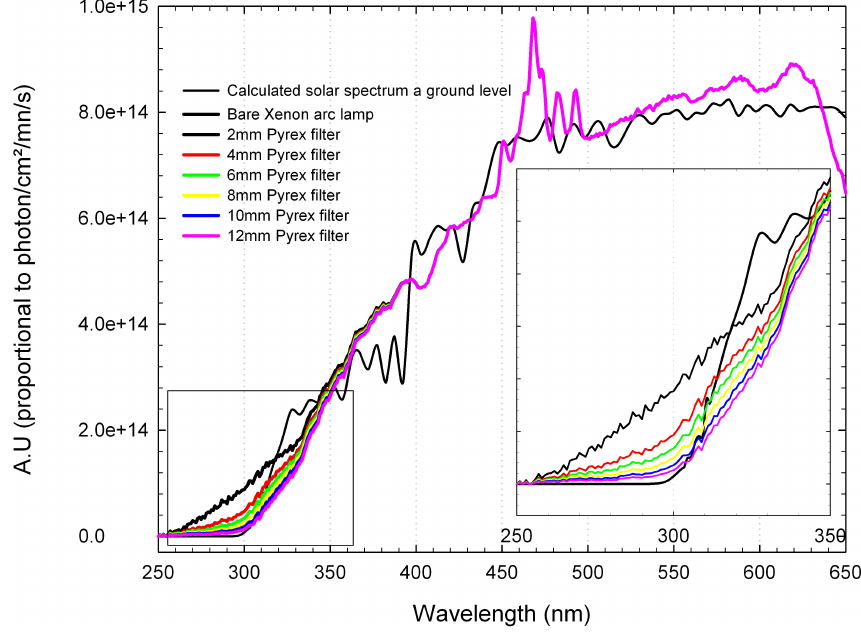
Fig. 4. Comparison of irradiation spectra. The thin black curve is solar spectrum calculated from TUV NCAR, 12h, Equator, 21 June. The thick color curves are spectra of xenon filtered by different thicknesses of Pyrex films (the solar spectrum is scaled to the lamps spectra to facilitate comparison of their shapes).